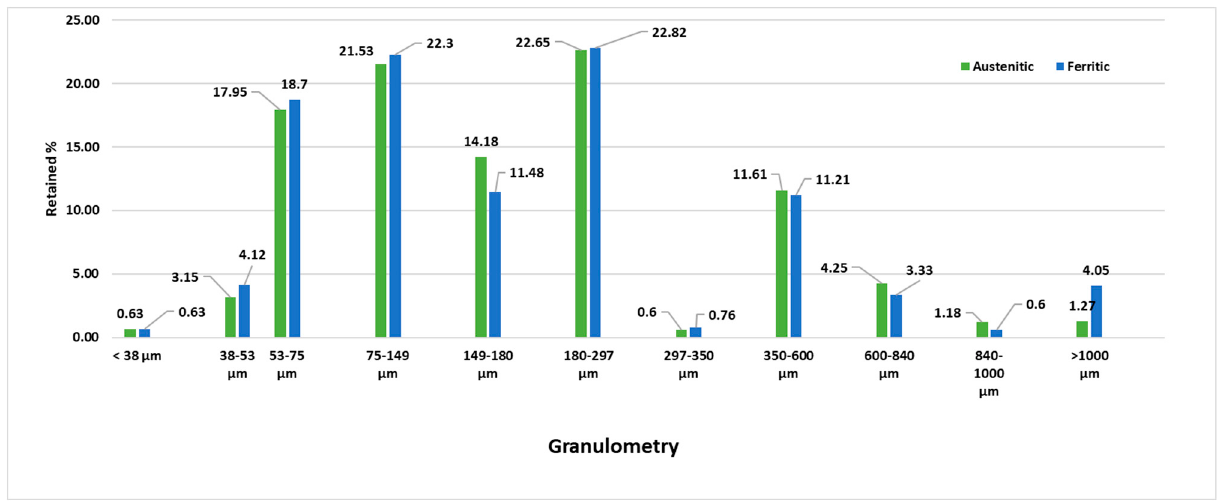
Figure 2. Granulometry of fume